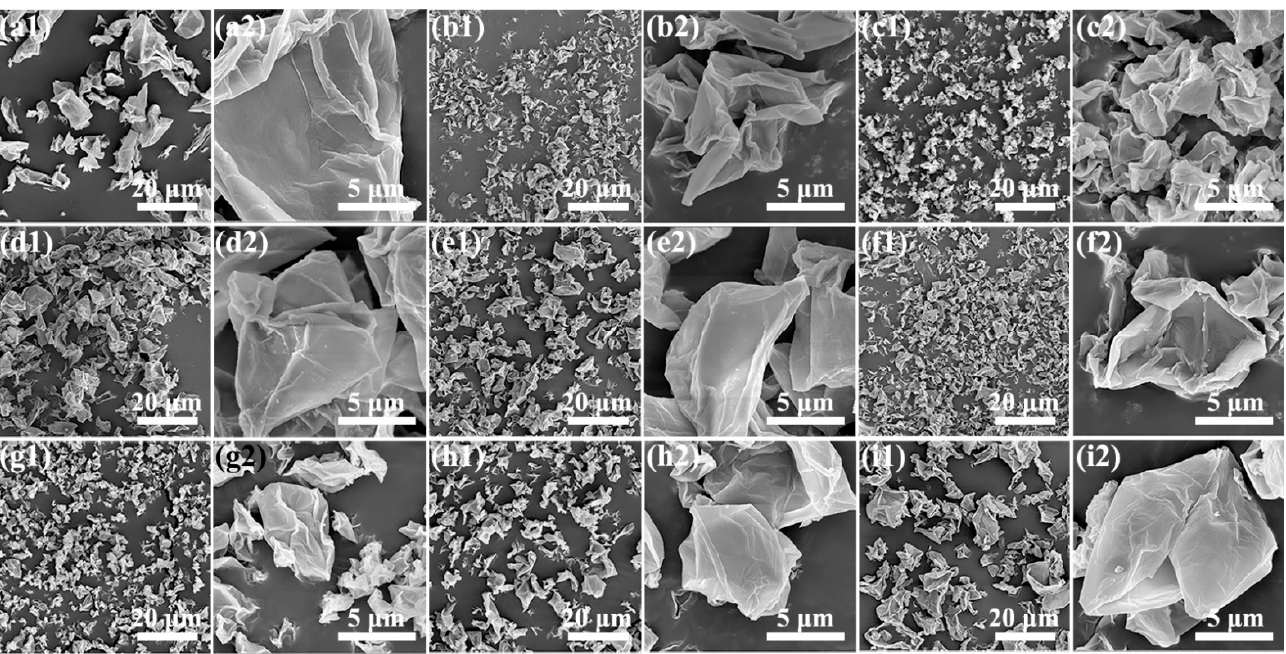
Figure 3. SEM images of GOPs with different ( a – c ) nozzle airflow rates/X 1 ( a1 , a2 : 283 L·h − 1 ; b1 , b2 : 667 L·h − 1 ; c1 , c2 : 1051 L·h − 1 ), ( d – f ) atomization pressures/X 2 ( d1 , d2 : 0.4 MPa; e1 , e2 : 0.6 MPa; f1 , f2 : 0.8 MPa), and ( g – i ) liquid feed rates/X 3 ( g1 , g2 : 3.0 mL·min − 1 ; h1 , h2 : 6.0 mL·min − 1 ; i1 , i2 : 9.0 mL·min − 1 ).